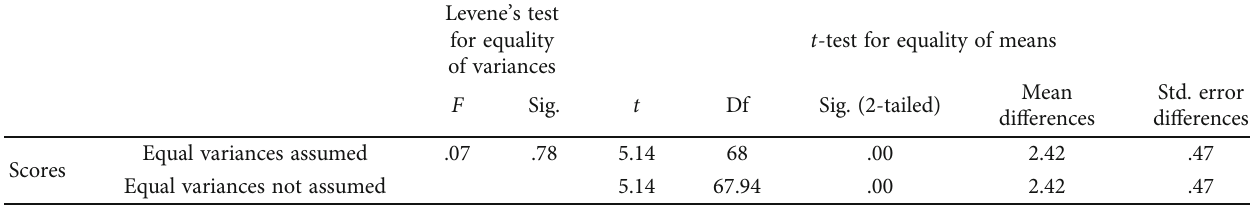
Table 4: Inferential statistics of both groups on the listening